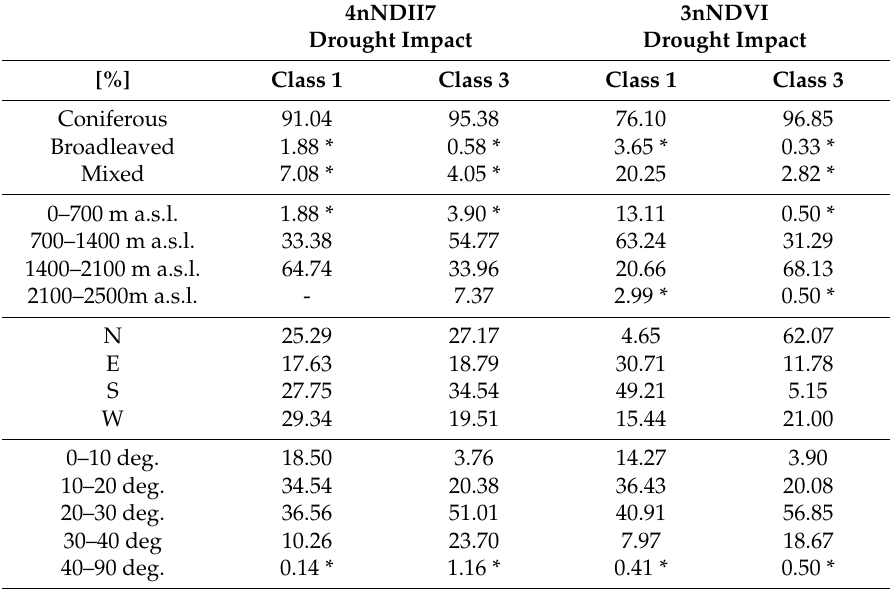
Drought footprints of the 4nNDII7 and 3nNDVI PCs (Figure 2a,b, respectively), inspected within four multilevel environmental factors of forest type, elevation, exposition and aspect. Class 3 denotes regions with the strongest positive, whereas class 1 the strongest negative fit to the respective PCs depicted in Figure